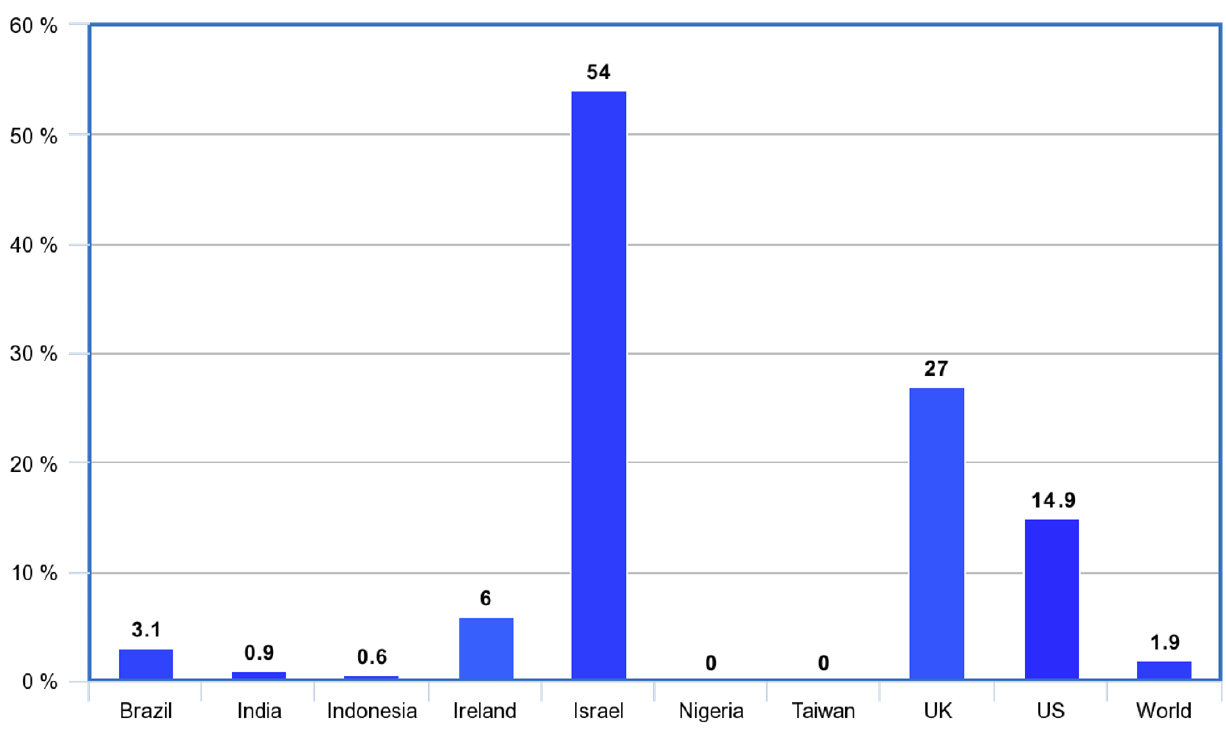
Figure 1. Percentage of population to receive at least one COVID ‐ 19 vaccine dose: 28 February 2021 [1].